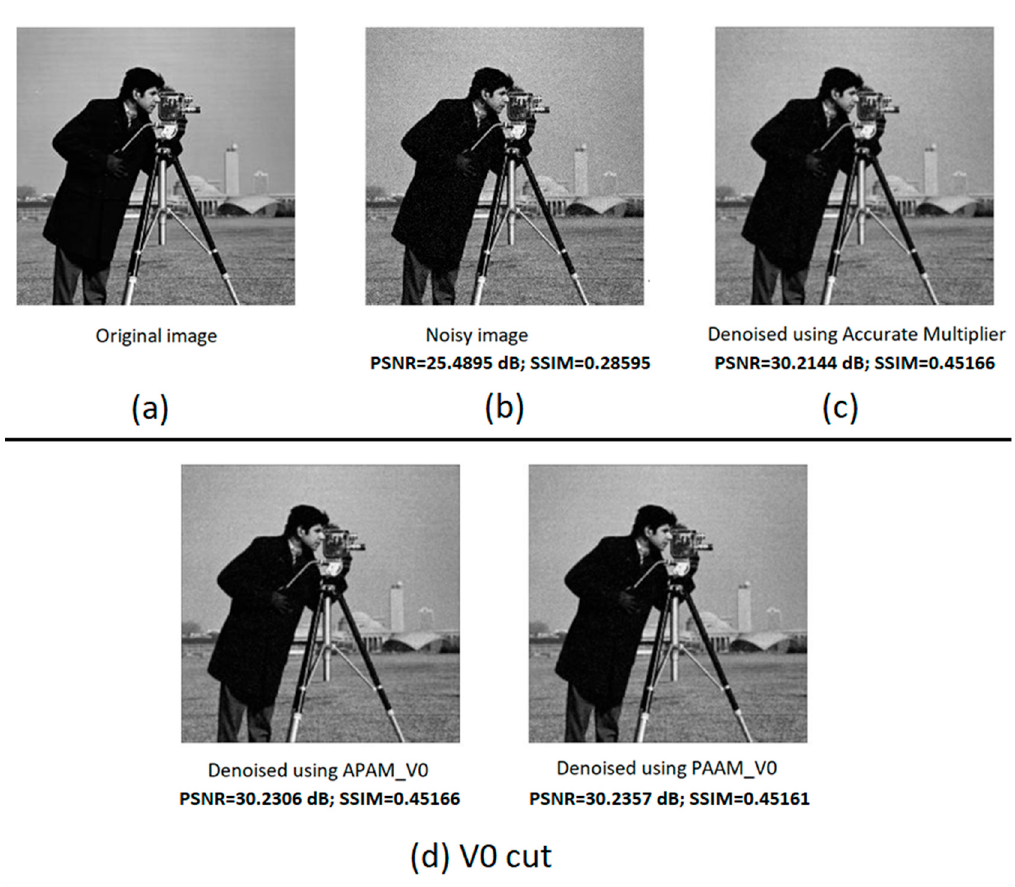
Figure 6. ( a ) Original image; ( b ) noisy image; (c) denoised image obtained using accurate multiplier; ( d ) denoised images obtained using approximate array multiplier APAM_V0 and the proposed approximate array multiplier PAAM_V0.